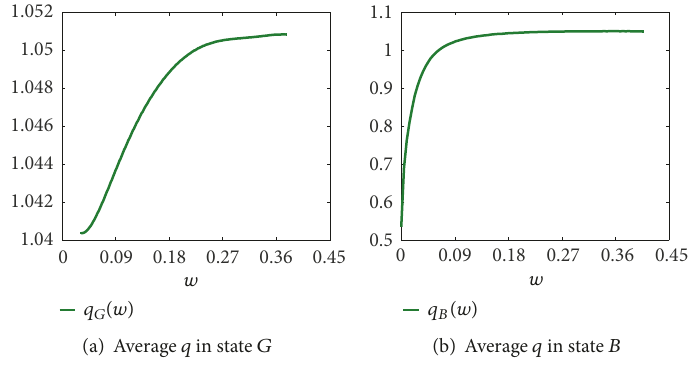
Figure 3: Average 𝑞 with time consistency in both states.